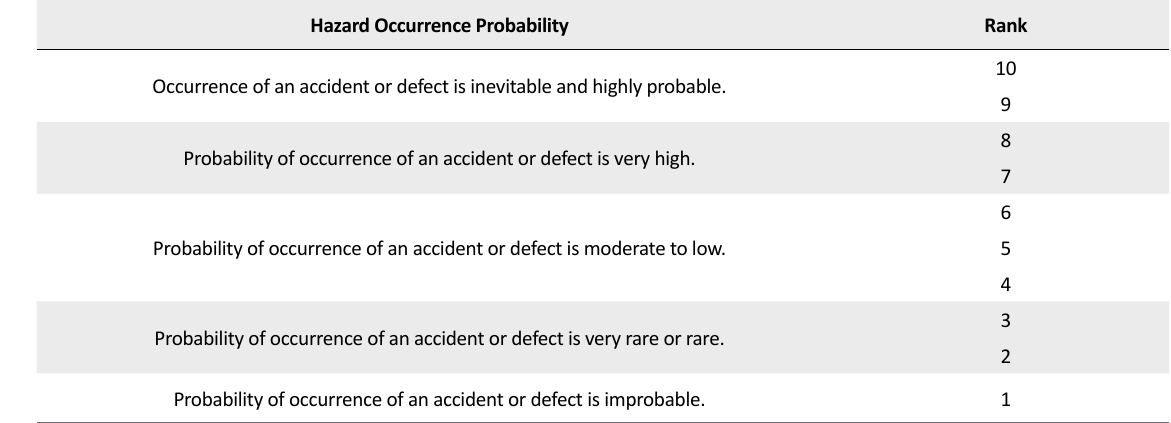
Table 2. Hazard occurrence probability Hazard Occurrence Probability Rank Occurrence of an accident or defect is inevitable and highly